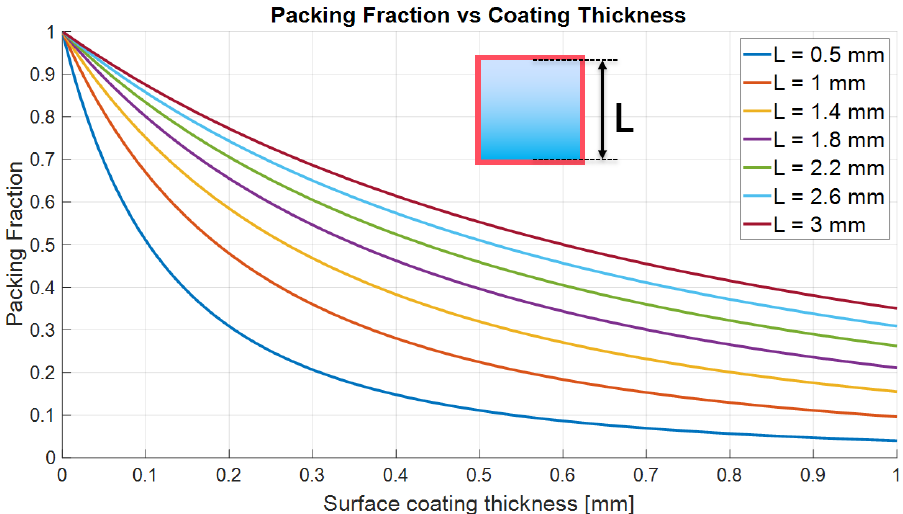
Figure 4. Coating thickness impact on the packing fraction. The coating thickness becomes non- negligible when reducing the crystal size (L), thus affecting the overall efficiency of the